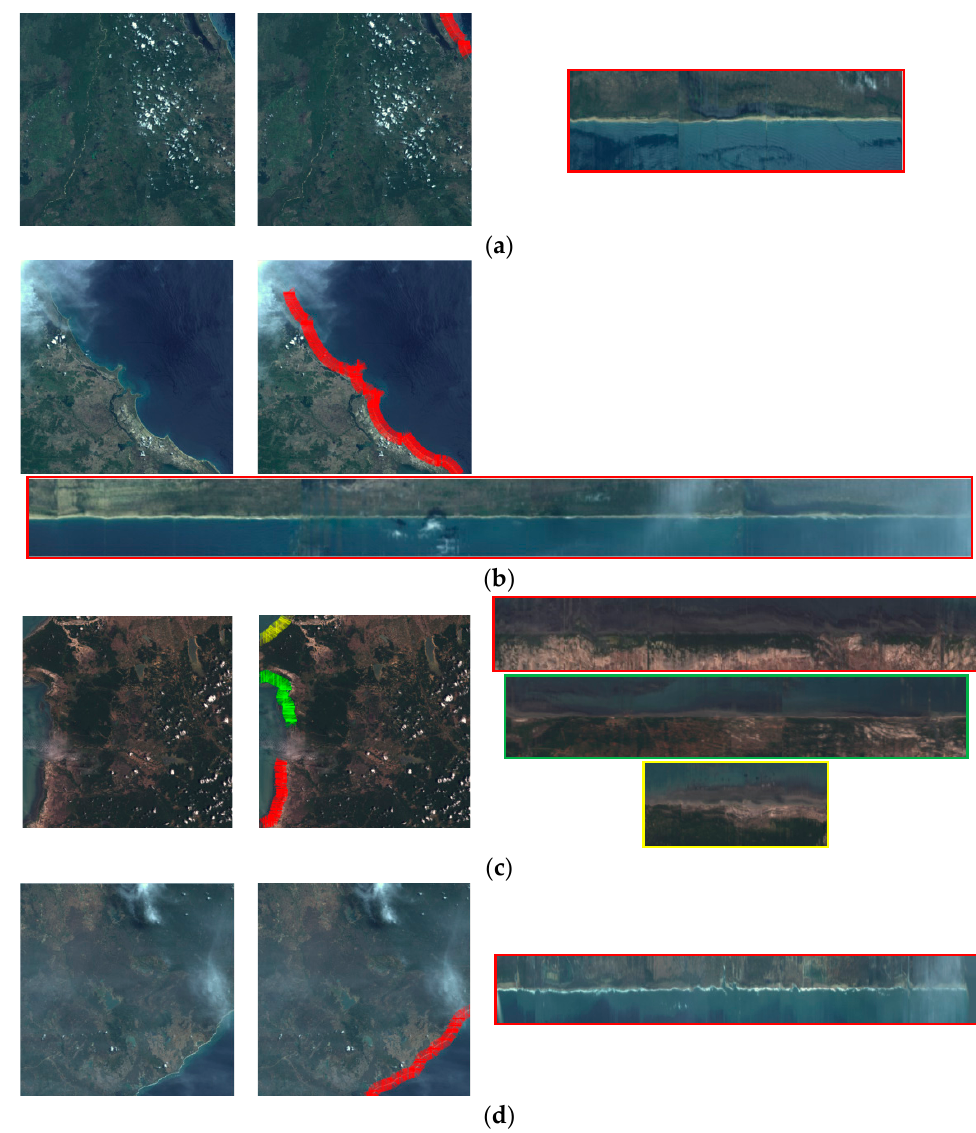
Figure 16. Effect of coastline straightening: ( a ) short shoreline straightening effect; ( b ) long coastline straightening effect; ( c ) multi-shoreline straightening effect; and ( d ) coastline straightening effect of cloud occlusion.